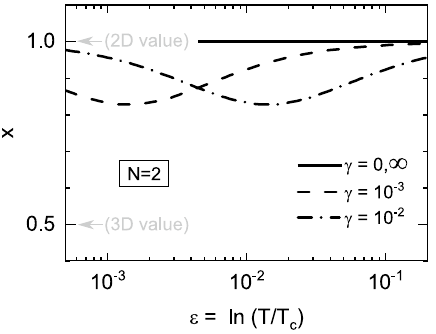
Fig. 4 Fluctuation specific heat c fl from our expressions for two- layer superconductors, as a function of the reduced temperature 𝜀 and for different values of the Josephson coupling 𝛾 . The c given in arbitrary units (and is proportional to the also observables − 𝜒 ∕ T and 𝜎 fl flAL ). See also Figs. 5 and 6 for an interpretation of the results